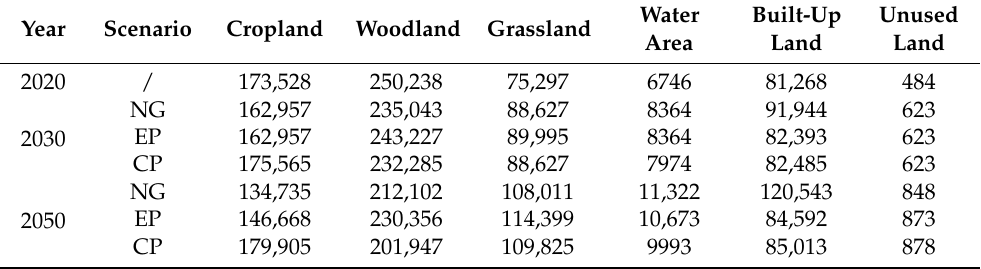
Table 3. The land demand of each land-use type under the three